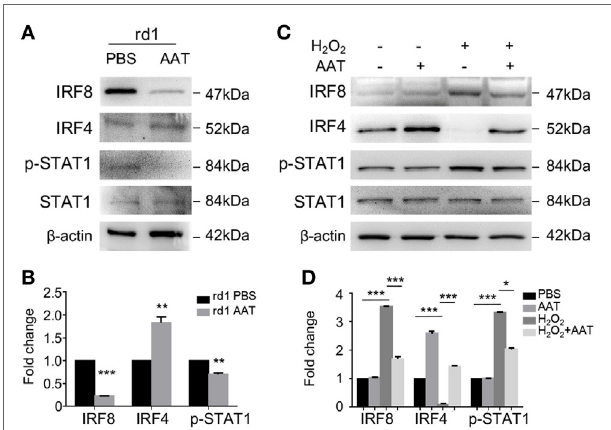
FigUre 8 | Alpha-1 antitrypsin (AAT) modulated IRF4/8 activation and phosphorylation of STAT1 in vivo and in vitro . (a,B) Western blot revealed that in AAT-treated retina of rd1 mice, the IRF8 expression significantly decreased while the expression of IRF4 increased slightly. Moreover, the STAT1 signaling was suppressed after AAT supplement. (c,D) In vitro , hydrogen peroxide stimulation upregulated the expression level of IRF8 and promoted phosphorylation of STAT1 in the primary cultured microglia, while AAT treatment reversed the expression trend with decreased IRF8 and STAT1 and increased IRF4. n = 3. * p < 0.05, ** p < 0.01, *** p < 0.001 (two-tailed unpaired t -test).